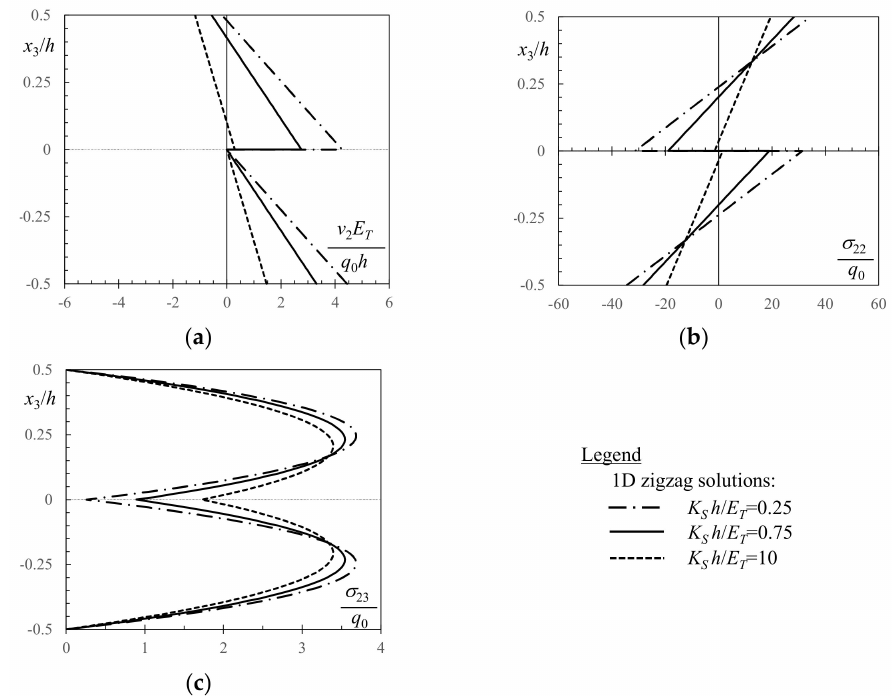
Figure 5. 1D zigzag solutions for simply supported two-layer beam (0 ◦ /0 ◦ ) with L / h = 5 subjected to uniform transverse load: ( a ) local longitudinal displacements (at x 2 = 0); ( b ) bending stresses (at x 2 = 0.5 L ); ( c ) transverse shear stresses (at x 2 = 0) determined from local